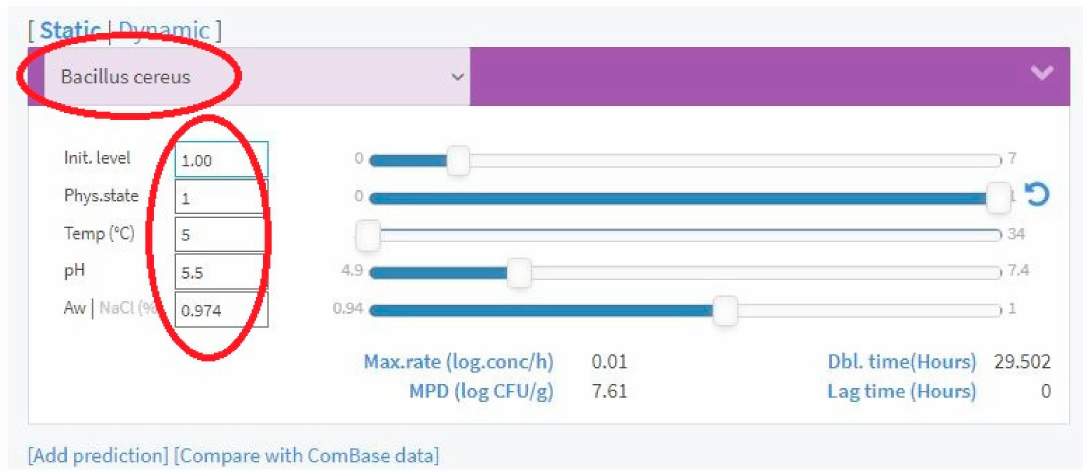
Figure 3. Inputs required for predicting bacterial growth in Combase